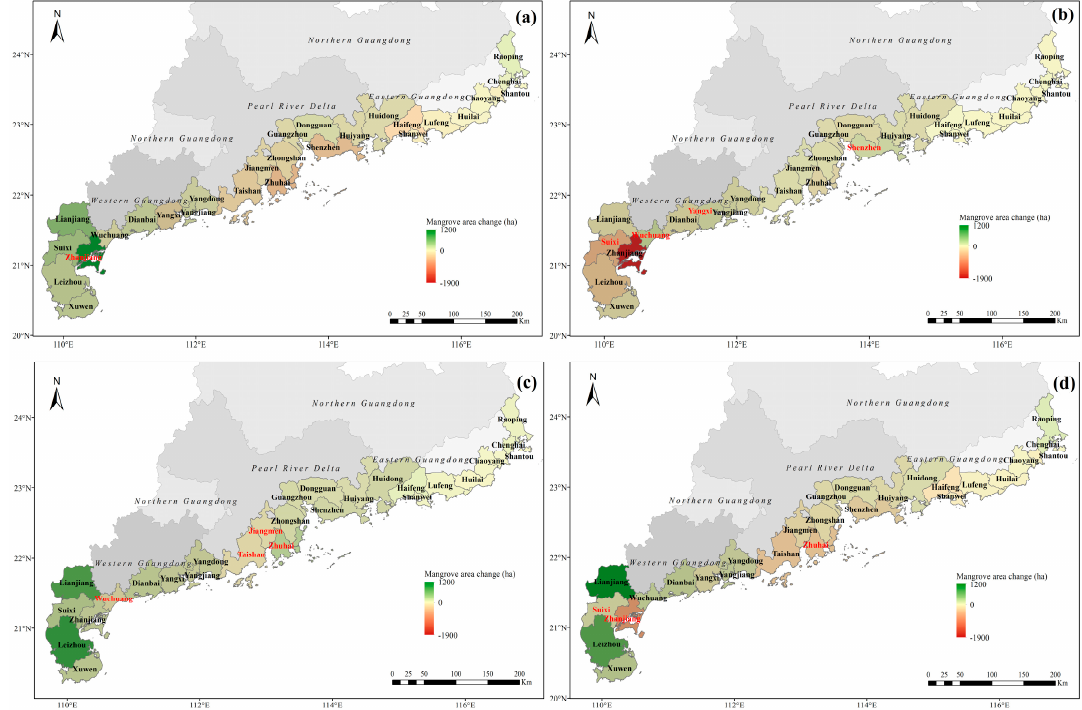
Figure 8. Temporal variation in the mangrove distribution at county and city level (Negative value means decrease, and positive value means increase): ( a ) from 1985 to 1995, ( b ) from 1995 to 2005, ( c ) from 2005 to 2015, ( d ) from 1985 to 2015.